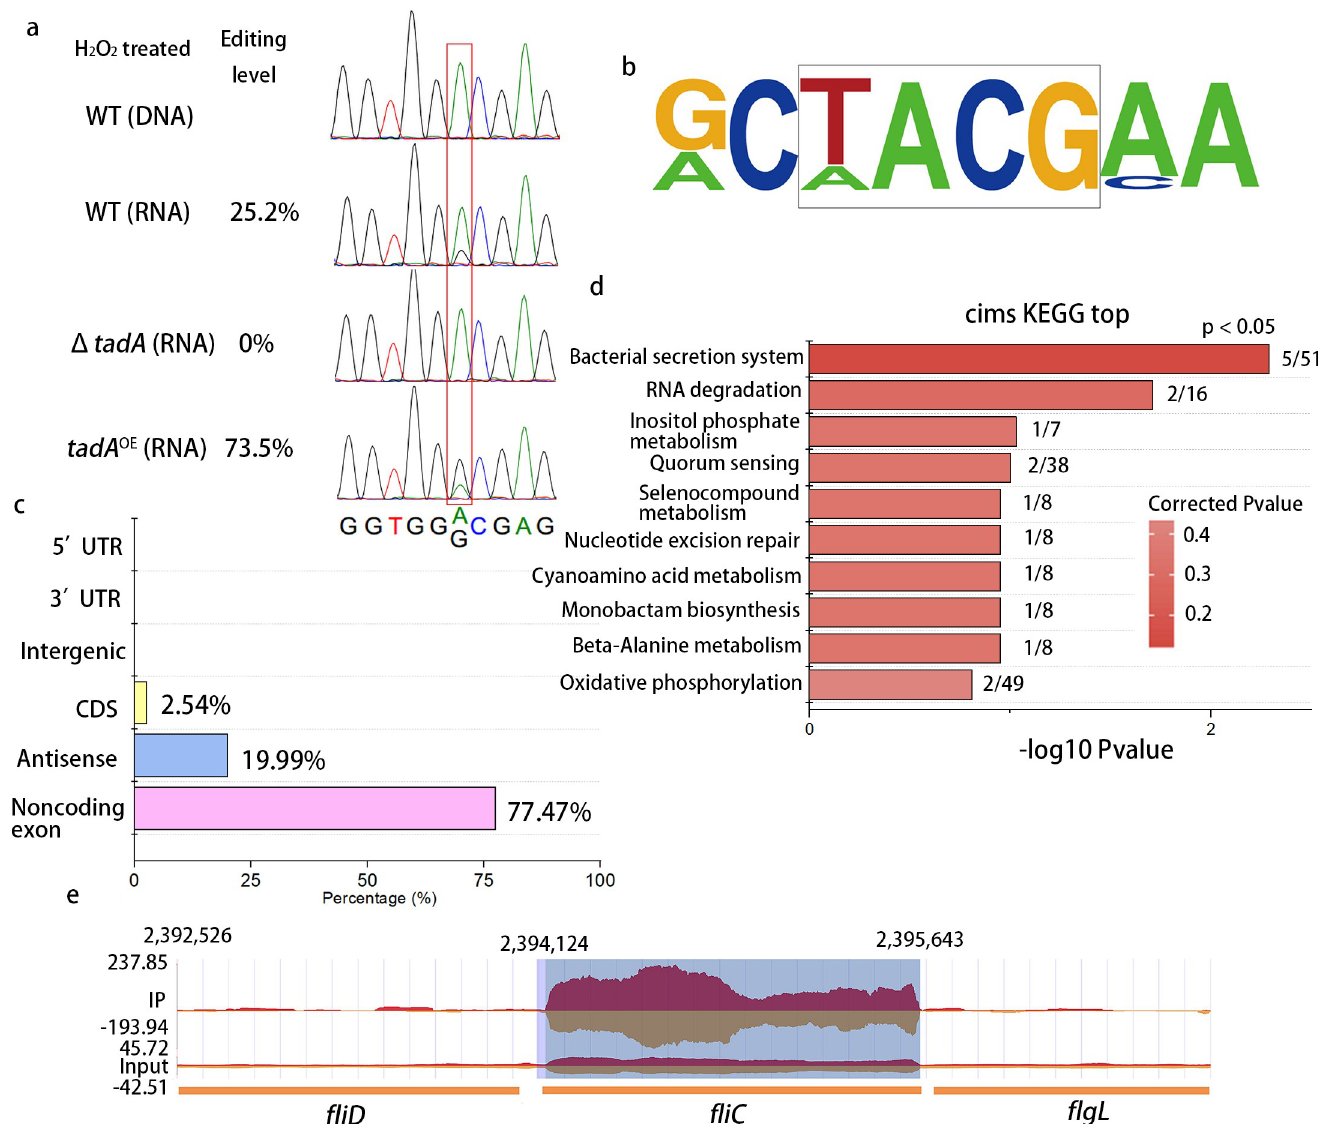
Fig 1. Analysis of the fliC (S128P) A-to-I RNA editing event by Sanger sequencing, RNA-seq and iRIP-seq. (a) Sequence analysis of DNA (gDNA) and/or cDNA in edited regions of wild-type (WT), Δ tadA , and tadA o e . PCR fragments were obtained from genomic DNA or cDNA (mRNA) using primers described in Methods. Samples were exposed to 0.1 mM H 2 O 2 and then subjected to Sanger sequencing. Chromatograms show edited sites in gDNA and cDNA, and the percentage of edited sequence as determined by pyrosequencing is indicated. (b) Conserved motif in A-to-I edited sites based on RNA-seq. All sites share a conserved TACG motif that is identical to the four nucleotide sequence recognized by TadA. (c) Percentage of reads used for peak calling in iRIP-seq. (d) KEGG analysis of genes that were enriched in iRIP-seq. (e) Peaks that were called at fliC in the iRIP-seq